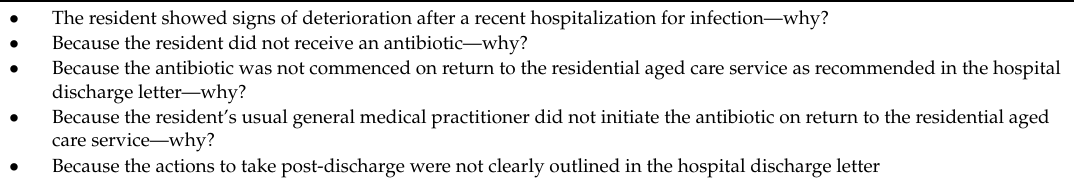
Table 1. Example of using the 5 why’s